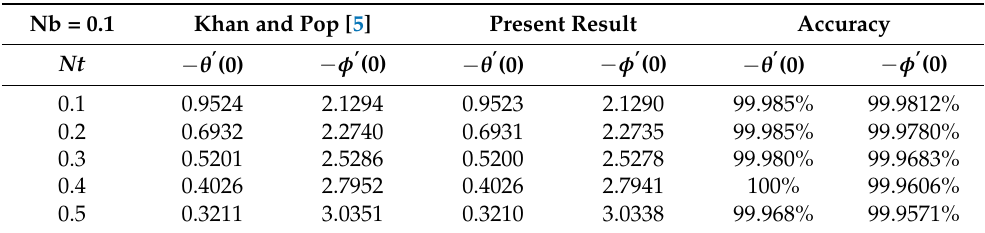
Table 2. Comparison of numerical values for θ (cid:48) ( 0 ) and φ (cid:48) ( 0 ) for dissimilar values of Nt when α = 1 and Sc = Pr = 10.